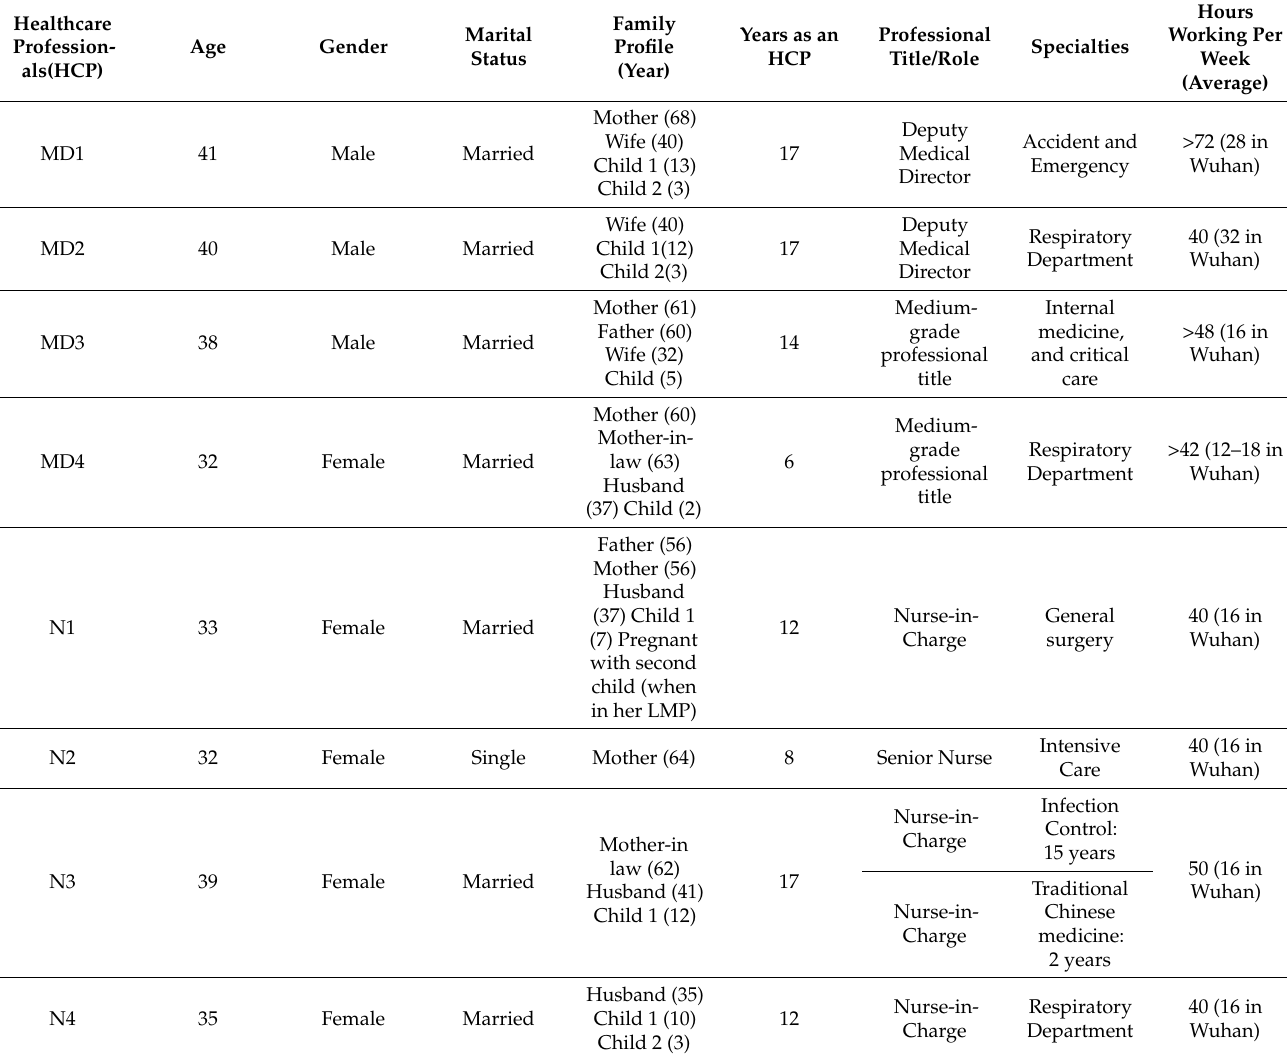
Table 3. Characteristics of the study